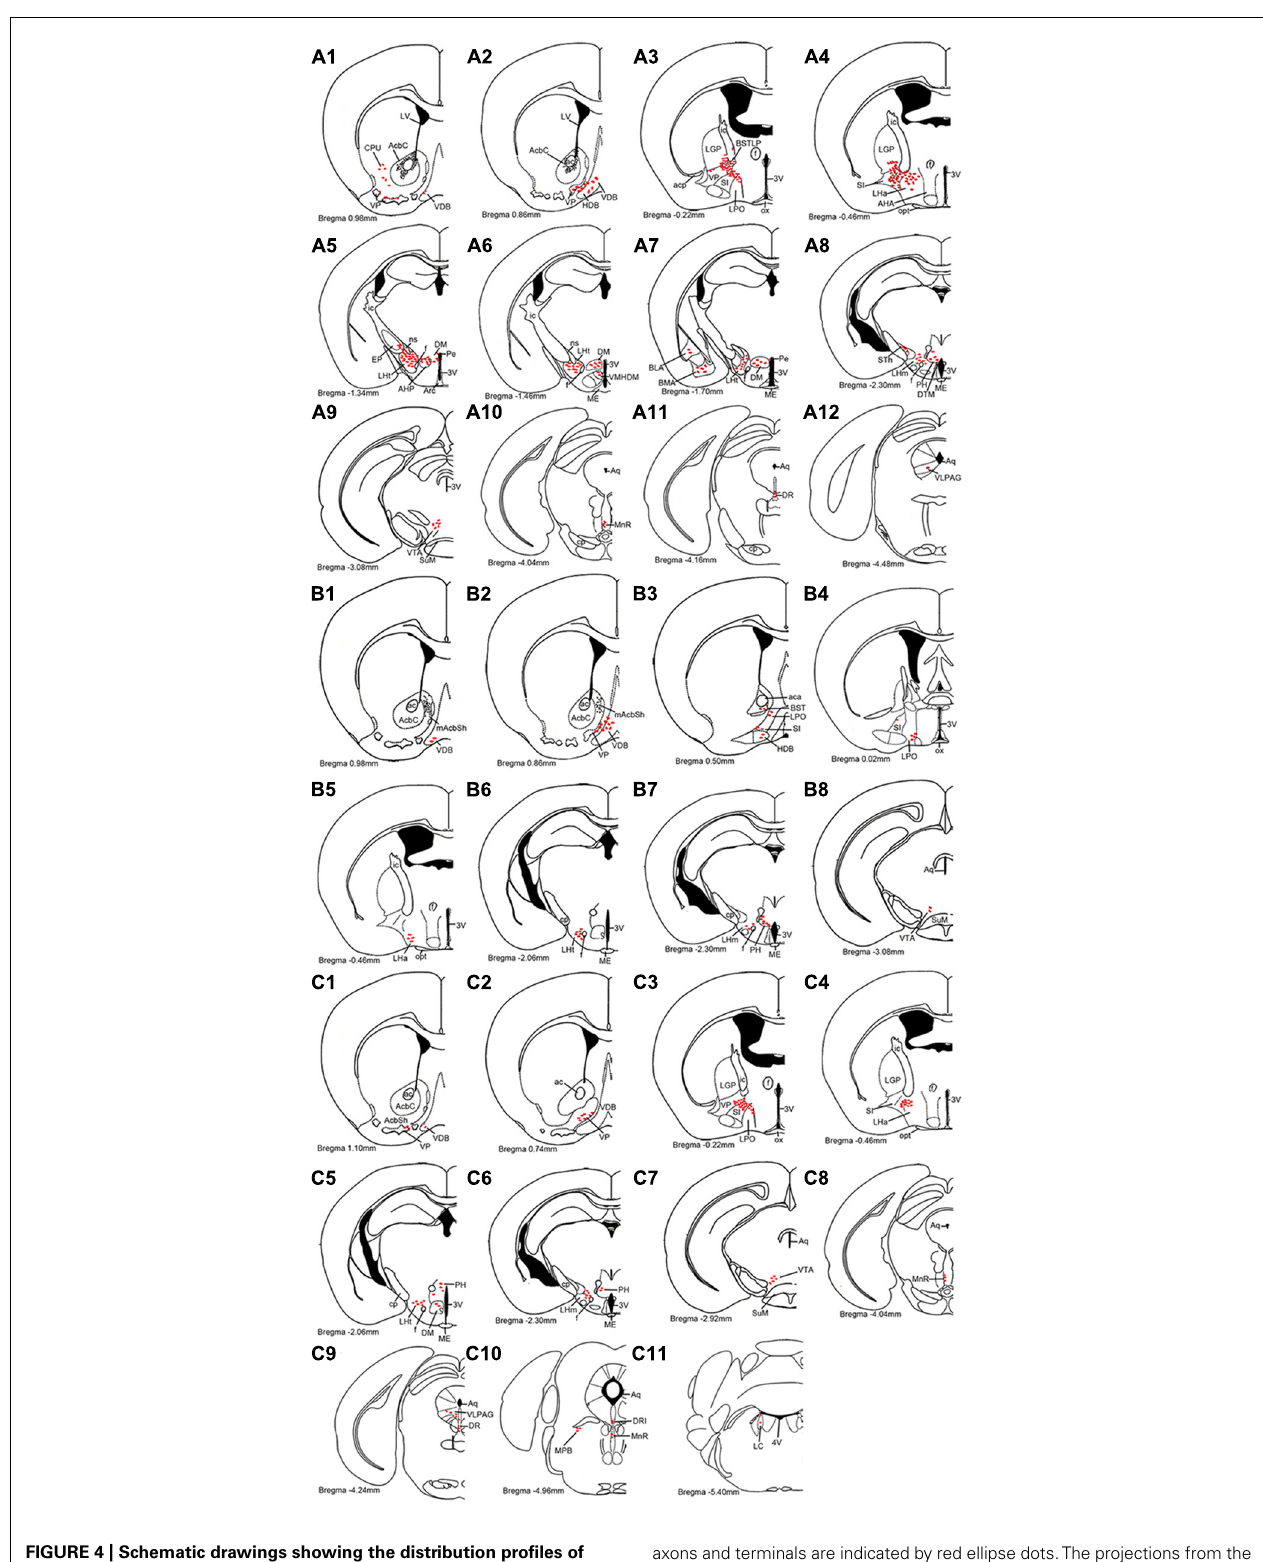
axons and terminals are indicated by red ellipse dots.The projections from the AcbC and ventral AcbSh extend more caudally than those from medial AcbSh. All abbreviations are defined in the abbreviation